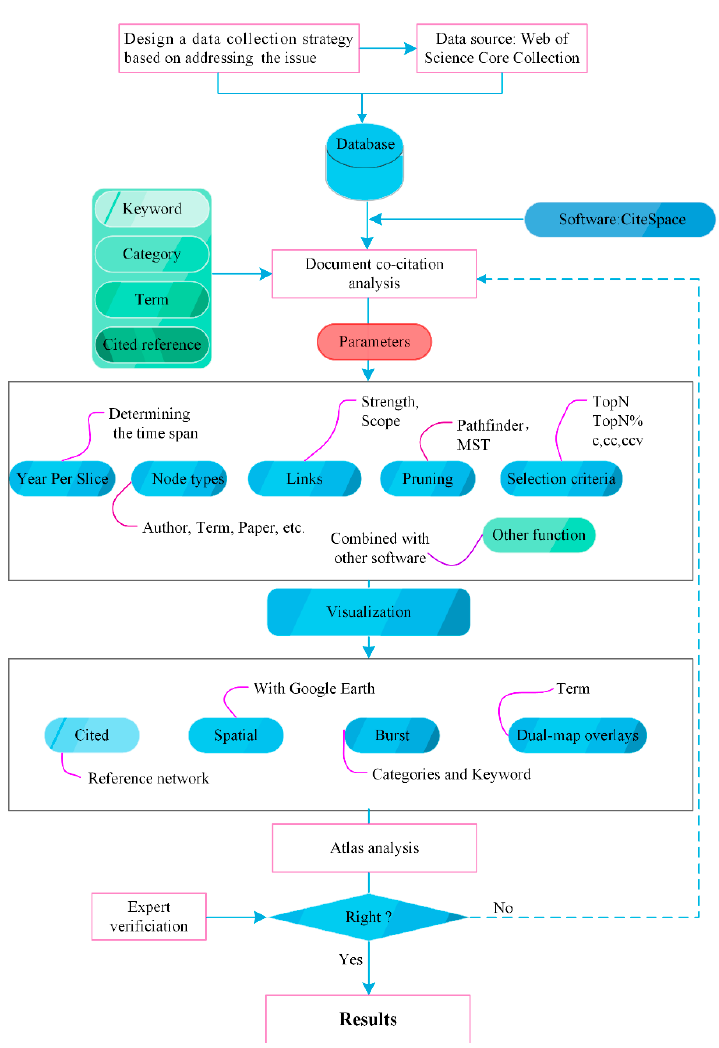
Figure 1 . Flow diagram of bibliometric analysis by CiteSpace. Noted that the MST represents the Minimum Spanning Tree.